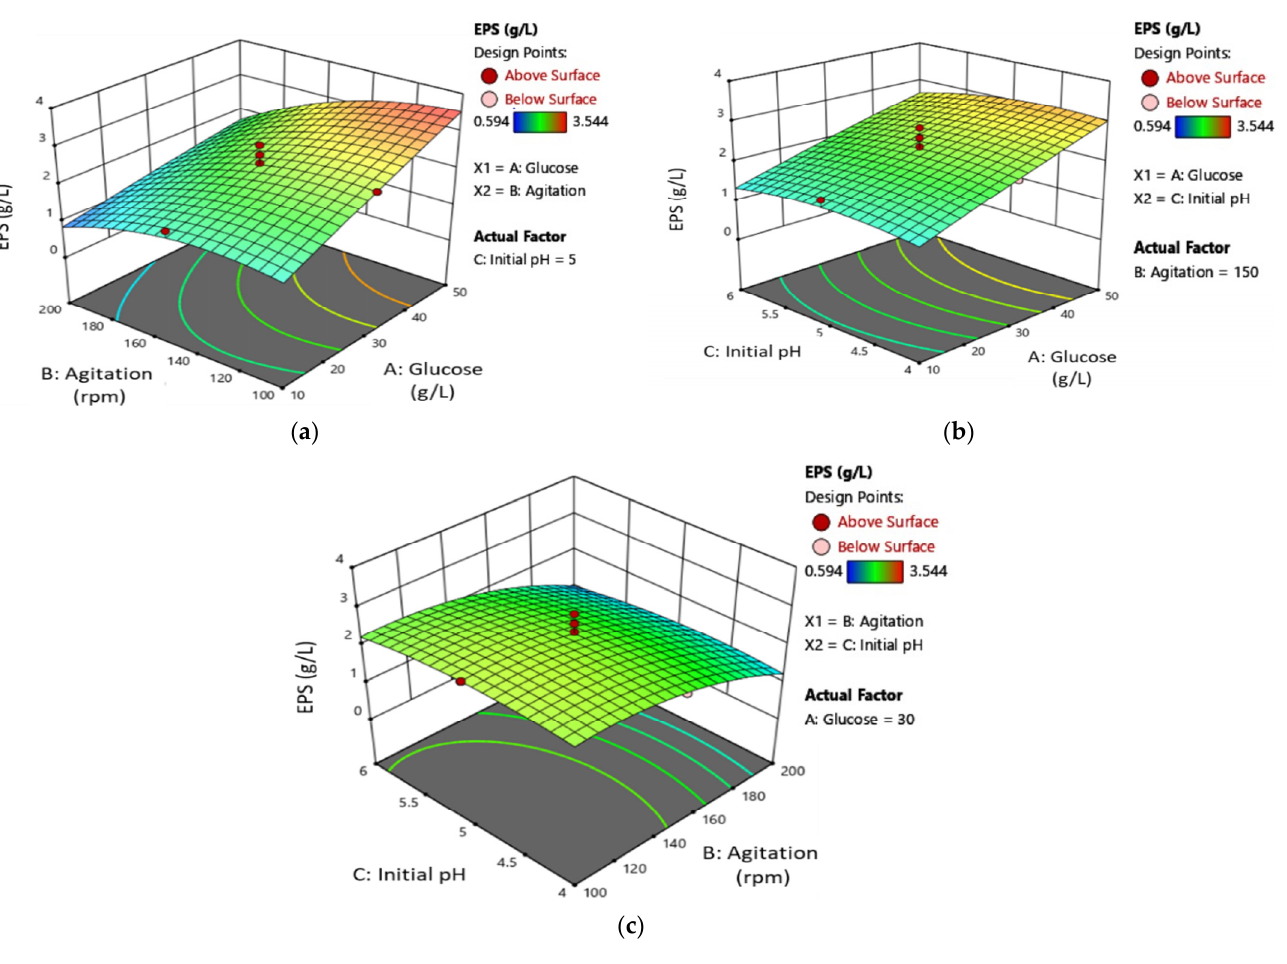
Figure 4. The three-dimensional (3D) response surface plot of L. rhinocerus’ EPS demonstrates the relationship for ( a ) speed of agitation and glucose concentration, ( b ) initial pH medium and glucose concentration, and ( c ) initial pH medium and speed of agitation.